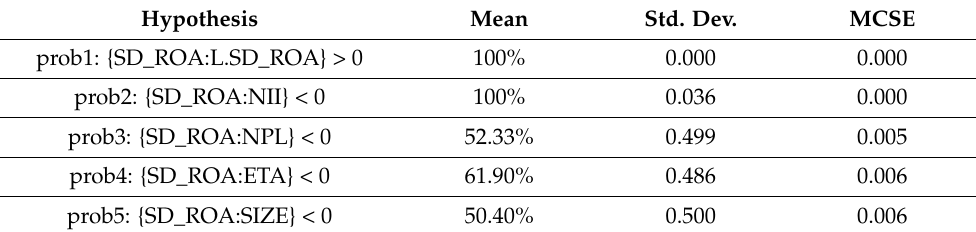
Table 8. Probability of regression